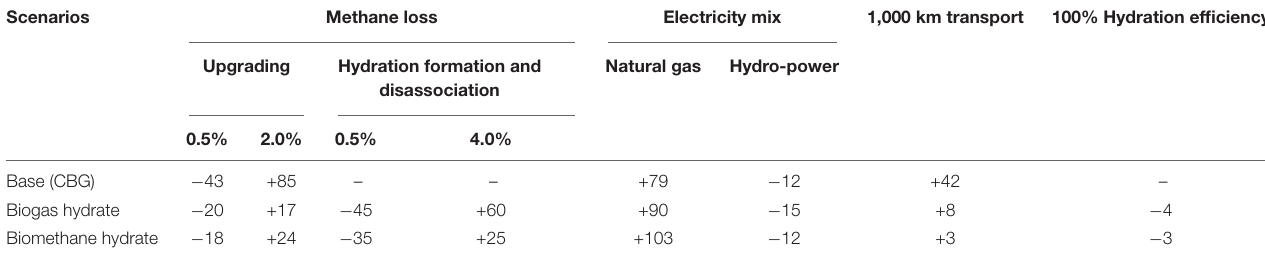
TABLE 7 | Change (%) in global warming potential per functional unit when selected input parameters were changed in the three scenarios studied.